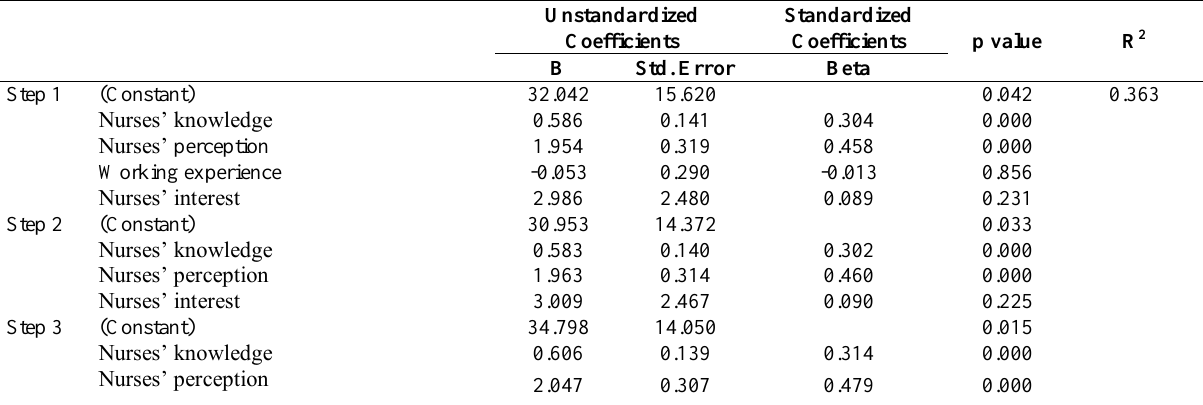
Table 4. Multivariate Analysis of the Dominant Related Factors with Nurses’ Self-Efficacy in Implementing of Providing PC in